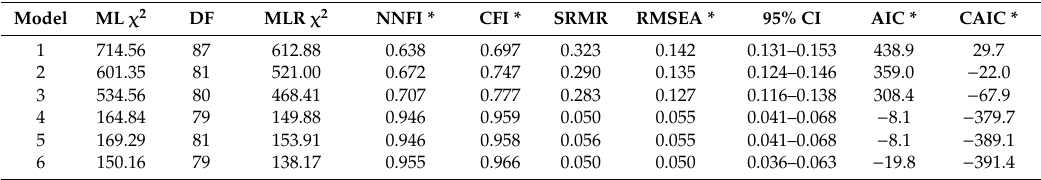
Table 2. Summary Table of Fit Statistics for Structural Equation